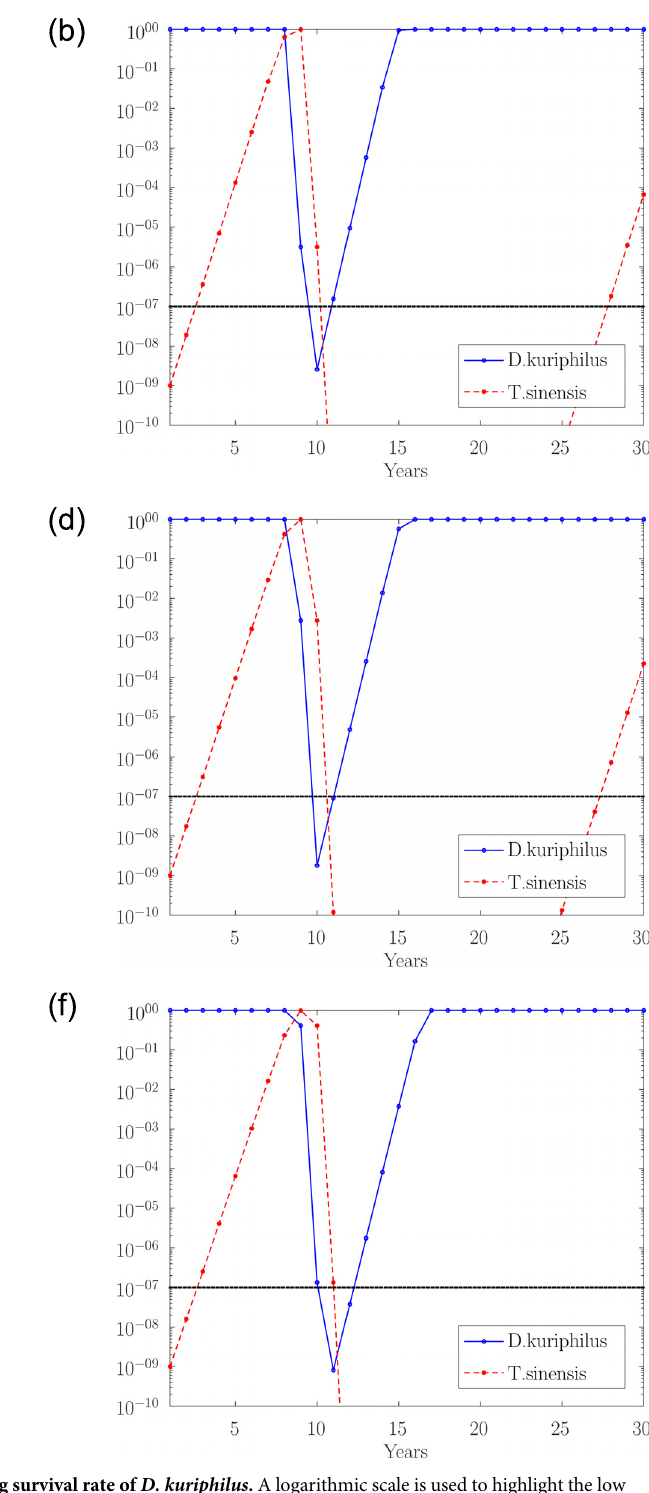
PLOS ONE | https://doi.org/10.1371/journal.pone.0254193 July 21,